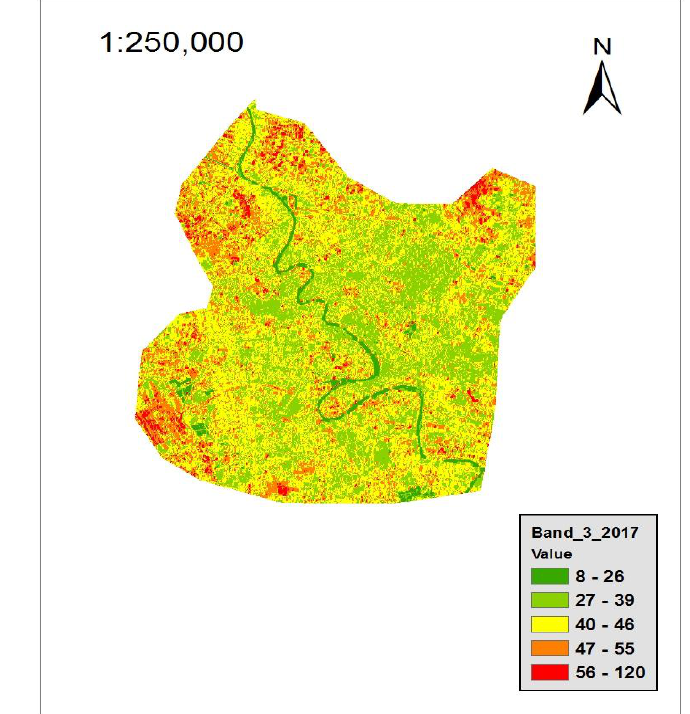
Fig.14: Show image classification of band (3) for study area in date (27/11/2017). 4- Calculate the value of (NDVI) for study area by using the tool (raster calculator) in Arcmap program through